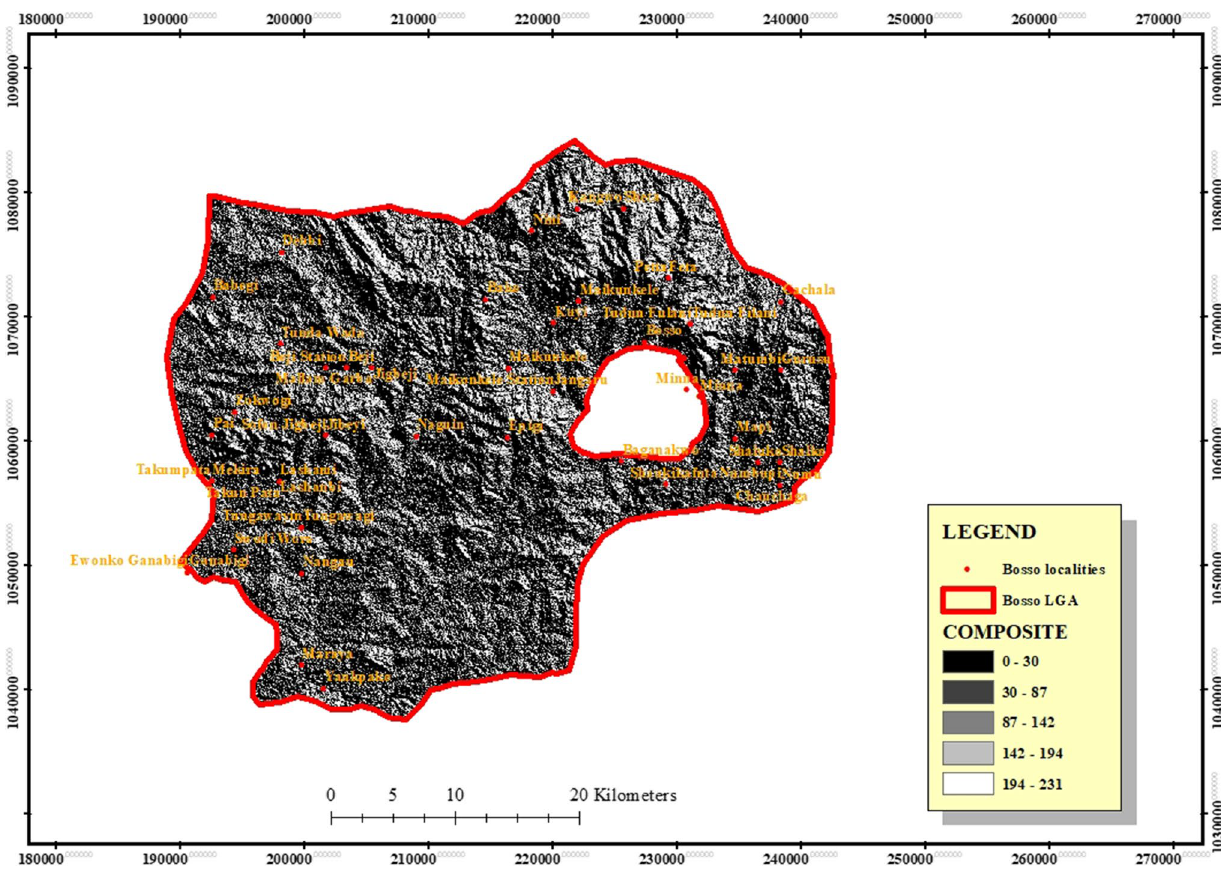
Fig. 4 Composite hillshade